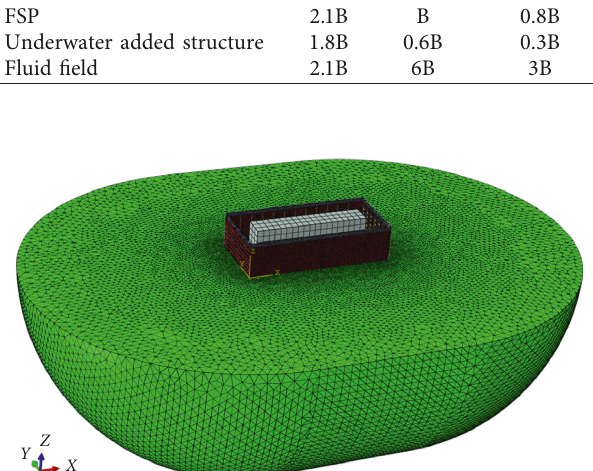
Figure 11: Finite element model subject to underwater explosion.